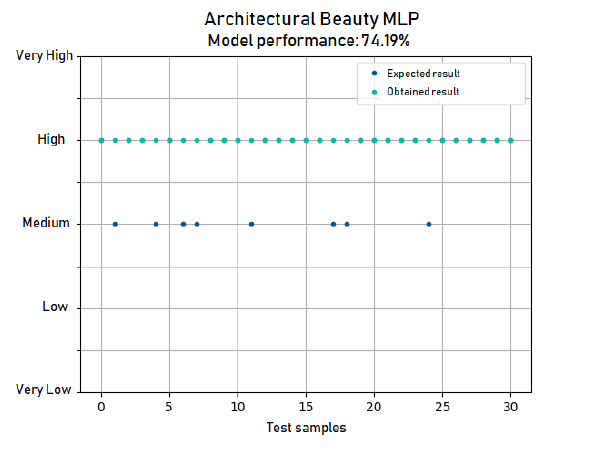
Figure 14. MLP for Architectural Beauty. Model Performance: 74.19%.